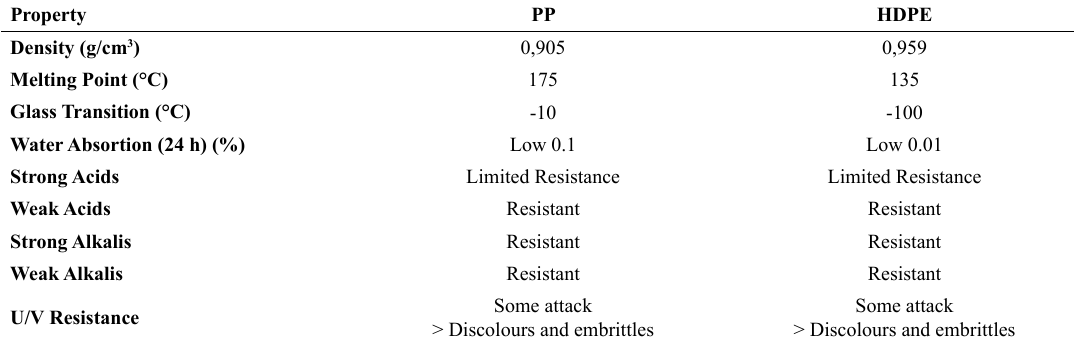
Some attack > Discolours and